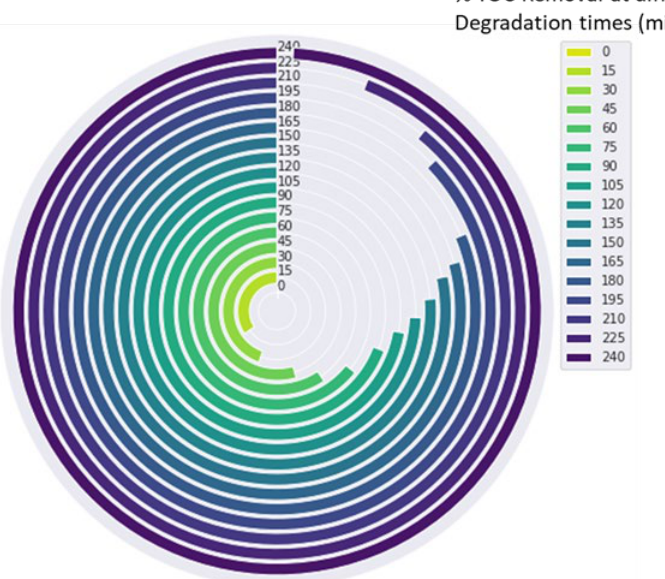
Figure 8. A circular bar chart depicting the removal of TOC with increasing degradation